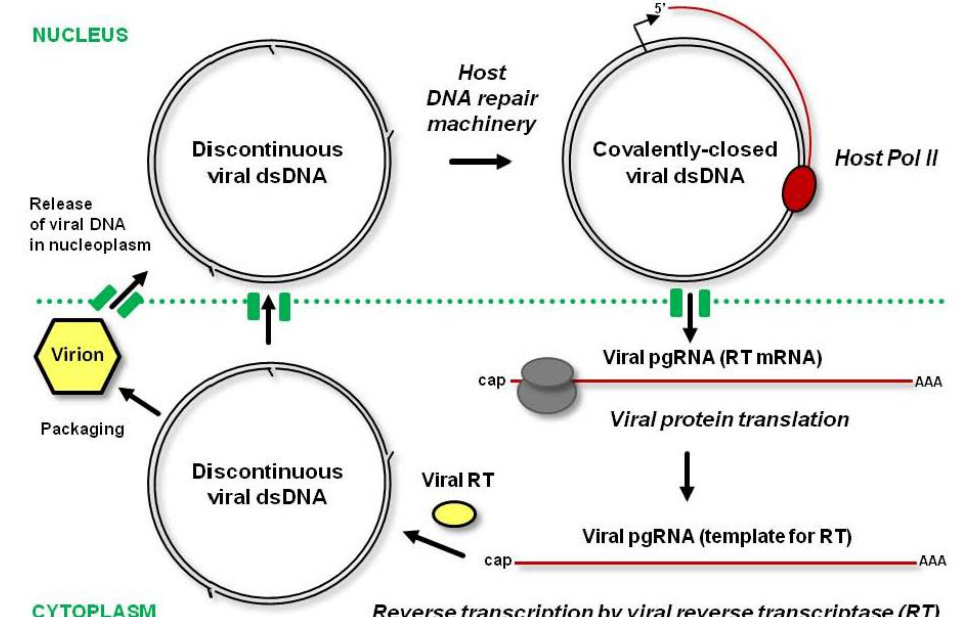
Figure 4. Model for pararetrovirus replication. Viral circular dsDNA from the virion (in yellow) is released into the nucleus. The gaps at both DNA strands are sealed by the host DNA repair machinery. The resulting covalently-closed dsDNA serves as a template for Pol II transcription generating viral pregenomic RNA (pgRNA). The capped and polyadenylated pgRNA is transported to the cytoplasm for translation of viral proteins including the reverse transcriptase (RT), and for subsequent reverse transcription catalyzed by RT. The resulting dsDNA with discontinuities at both strands can get packaged into a new virion or targeted to the nucleus for the next round of